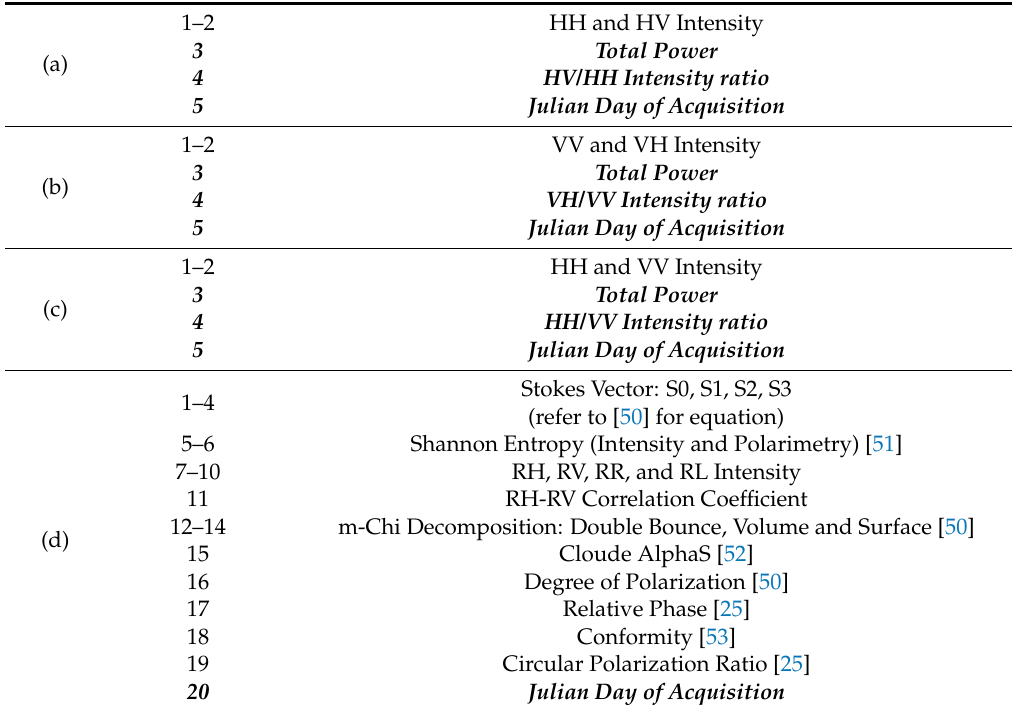
Table 8. List of predictor variables generated from simulated RCM: HH and HV (a); VV and VH (b); HH and VV (c); and CP (d) data for both high and medium resolution modes. Note variables bolded and italicized were calculated manually in PCI Geomatica.